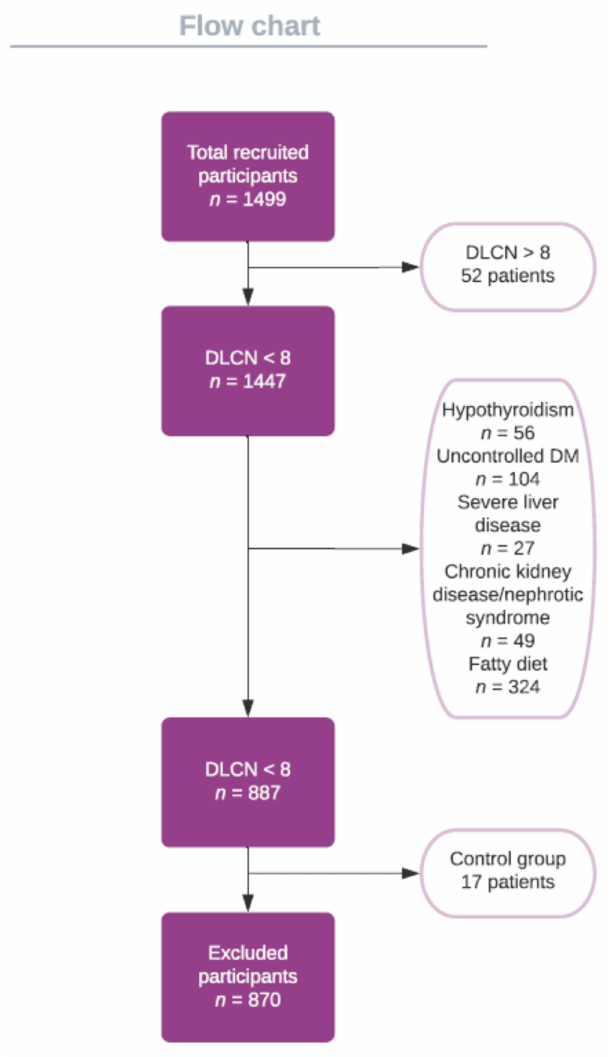
Figure 1. Flow chart of the studied